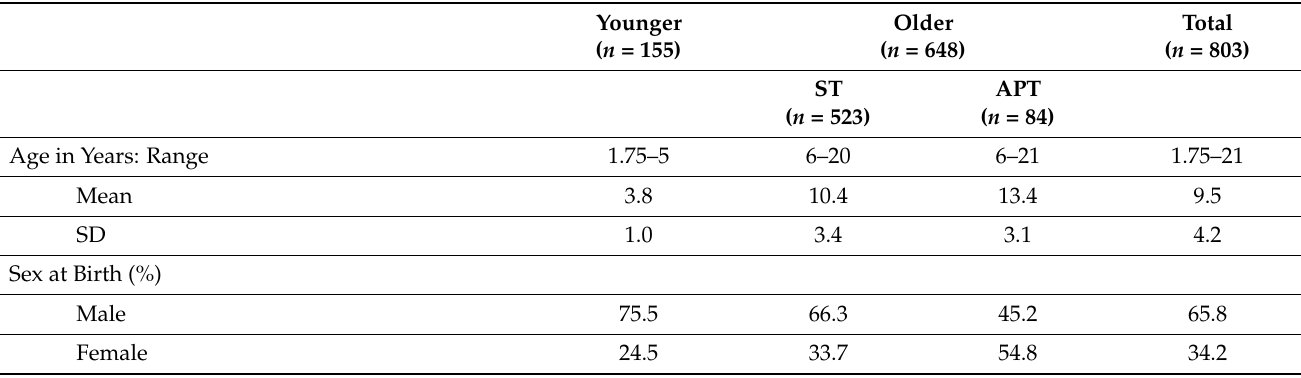
Table 1. Patient demographic data by age group and referral type, describing patient demographic